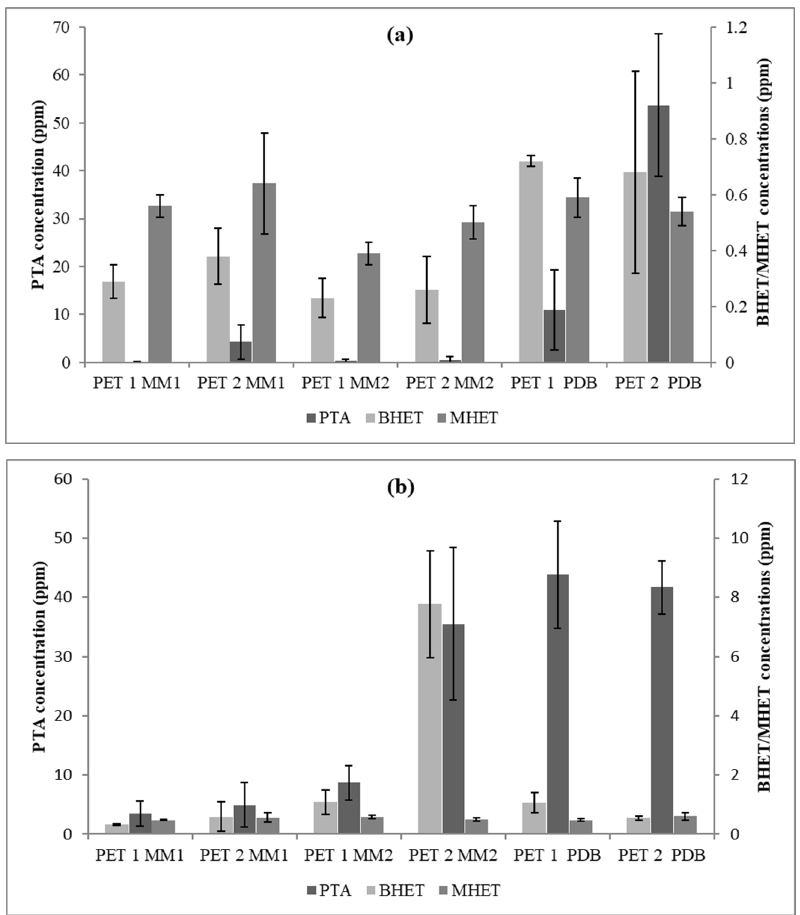
Figure 7. PTA, BHET, and MHET concentrations released from PET1 and PET2 with three different culture media (time = 40 days). ( a ) Trichoderma sp. CBMAI 2073; and ( b ) Cladosporium sp. CBMAI 2075.